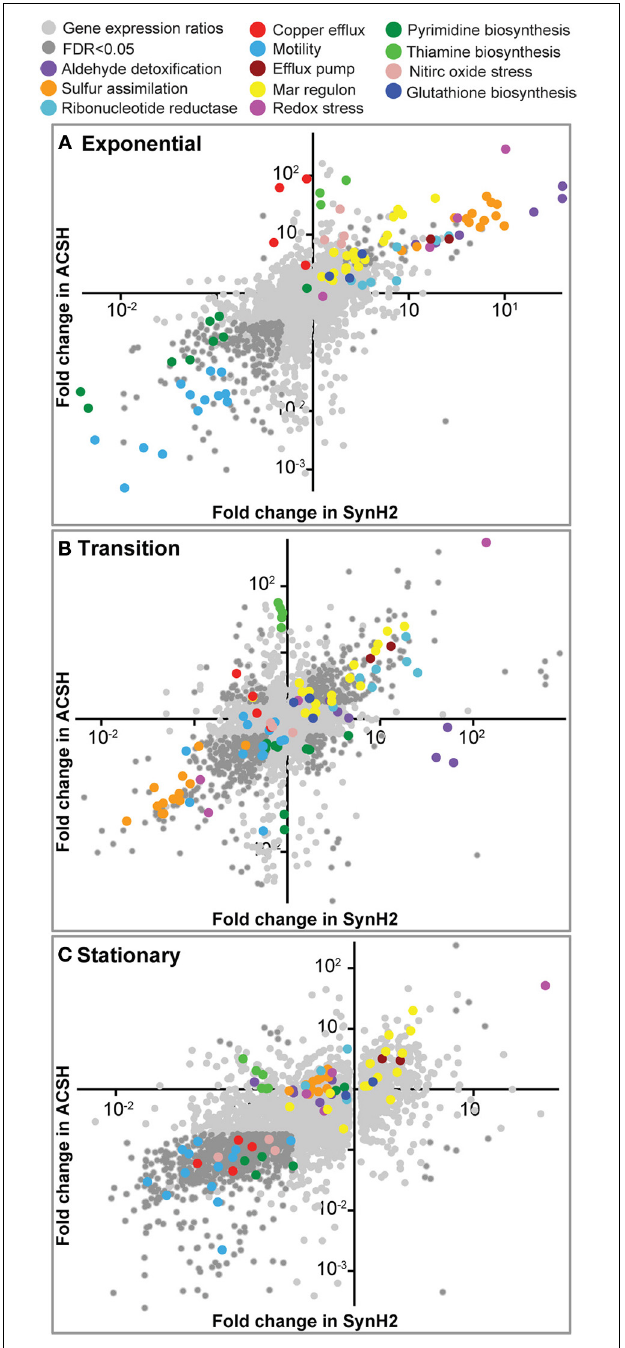
FIGURE 2 | Relative gene expression patterns in SynH2 and ACSH cells relative to SynH2 − cells. Scatter plots were prepared with the ACSH/SynH2 − gene expression ratios plotted on the y-axis and the SynH2/SynH2 − ratios on the x-axis (both on a log 10 scale). GLBRCE1 was cultured in a bioreactor anaerobically ( Figure 1 and Figure S5); RNAs were prepared from exponential (A) , transition (B) , or stationary (C) phase cells and subjected to RNA-seq analysis (Materials and Methods). Dark gray dots represent genes for which p = 0 . 05 for each expression ratio. Sets of genes with related functions that exhibited significant discrepant or parallel changes are color-coded and described in the legend at the top (see also Tables S3, S4,